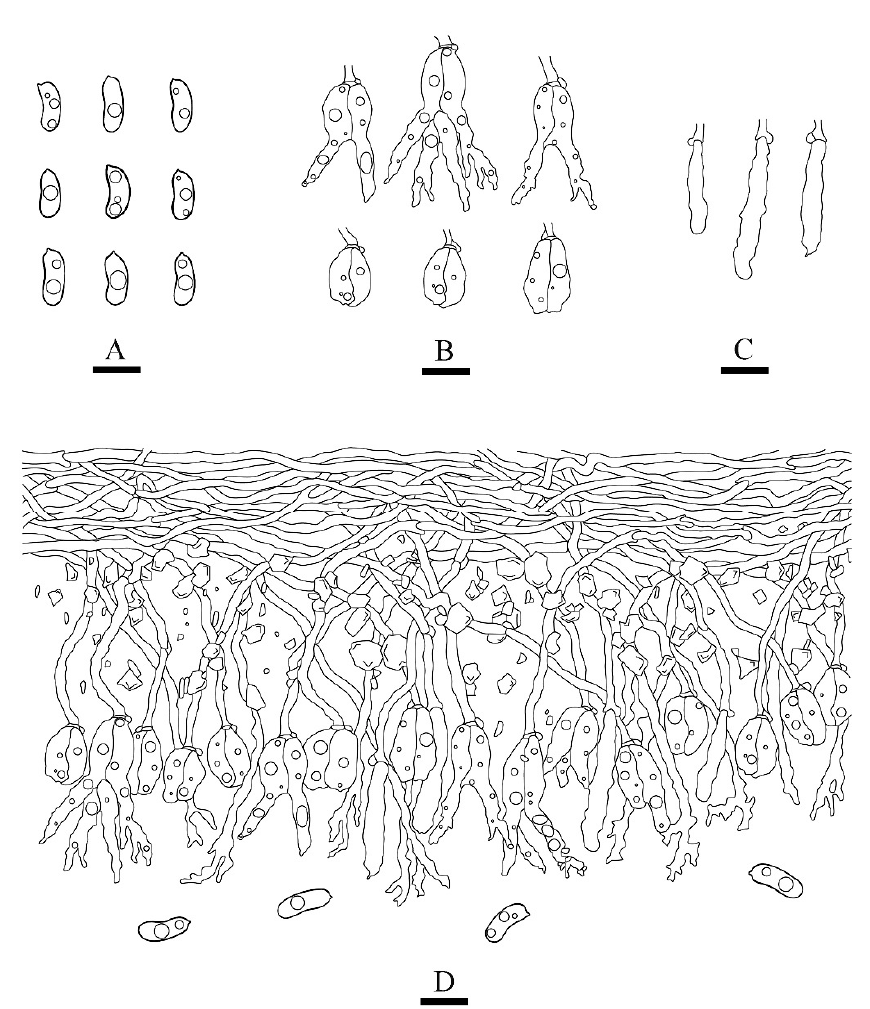
Figure 4. Microscopic structures of Heteroradulum niveum (holotype): basidiospores ( A ); basidia and basidioles ( B ); cystidia ( C ); A section of hymenium ( D ). Bars: ( A – D ) = 10 µm.